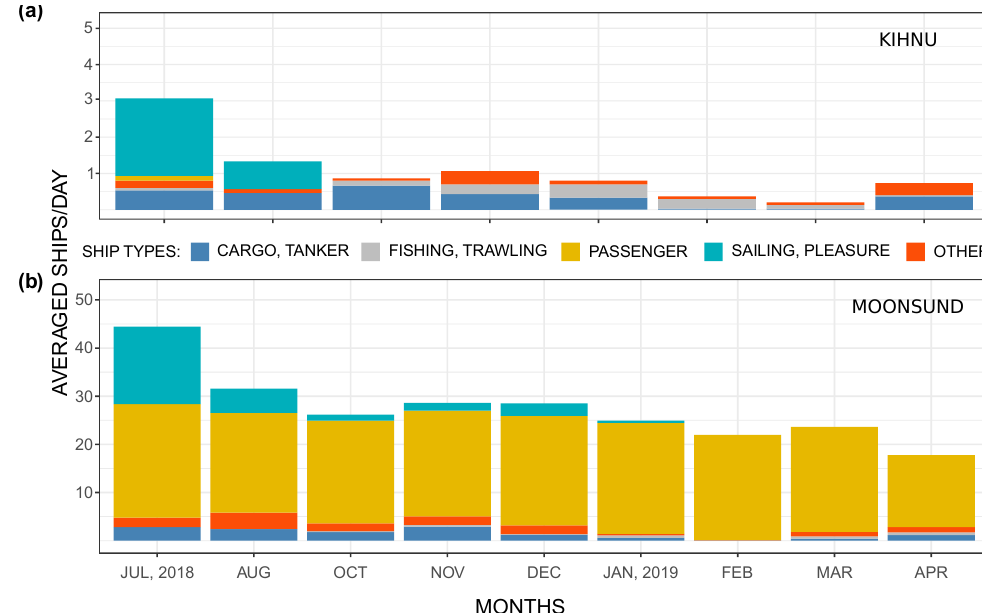
Figure 3. Monthly averaged numbers of ships per day based on automatic identification system (AIS) position reports within 10 km radius from the sound monitoring locations: ( a ) Kihnu and ( b )